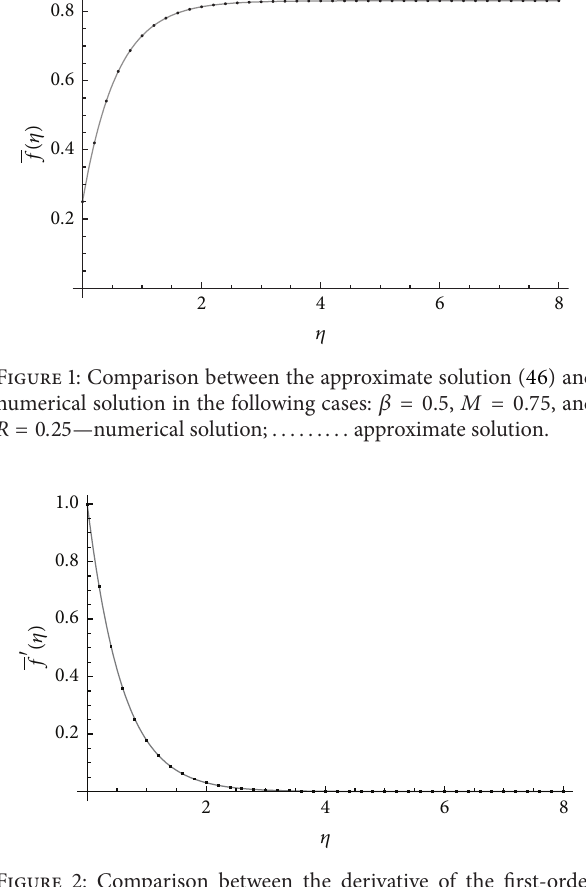
Figure 2: Comparison between the derivative of the first-order approximate solution of (46) and numerical solution in the follow- ing cases: 𝛽 = 0.5 , 𝑀 = 0.75 , and 𝑅 = 0.25 —numerical solution; ......... approximate